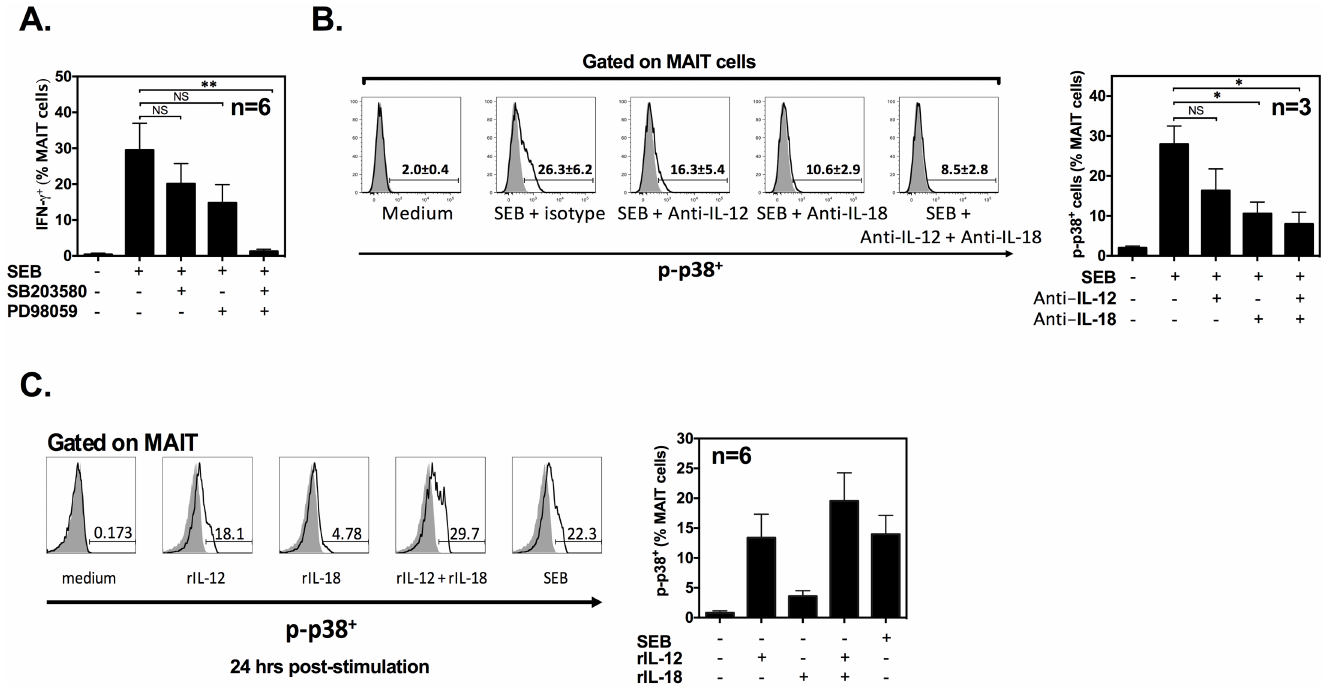
Fig 7. IL-12/IL-18-mediatedtransactivation of mucosa-associated invariant T (MAIT) cells following staphylococcal enterotoxin B (SEB) stimulation requires signaling through p38 and MEK1/2. Human peripheral blood mononuclear cells (PBMCs) ( n = 6) were exposedto SEB in the absenceor presenceof 20 μ M SB203580and/or PD98059, and intracellularinterferon(IFN)- γ accumulationin MAIT cells was detected after 24 h by flow cytometry ( A ). Intracellular phosphorylated p38 was traced in MAIT cells after stimulationwith SEB in the absenceor presenceof anti-IL-12and/or anti-IL- 18 monoclonal antibodies (mAbs). Representative FACS plots are shown along with a bar graph summarizingdata obtainedfrom 3 individuals ( * : p < 0.05; NS: non-significant) ( B ). In separateexperiments, PBMCs were left untreatedor exposedto SEB or to recombinant humanIL-12 (rIL-12) and/ or recombinant humanIL-18 (rIL-18) for 24 h before intracellular p38 phosphorylation in MAIT cells was analyzed( n = 6). Error bars represent SEM ( C ). The underlyingdata for this figure can be found in S1 Data, and our gating strategies are providedin S2 Data.